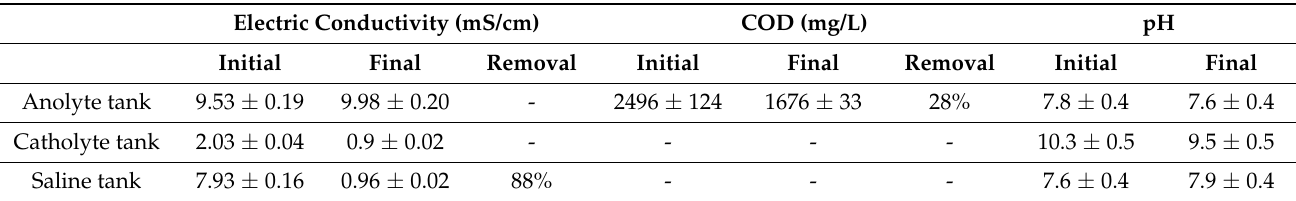
Table 2. Electric conductivity, COD removal in the anolyte tank, and pH changes during the desalination cycle (desalination time = 31 h). *